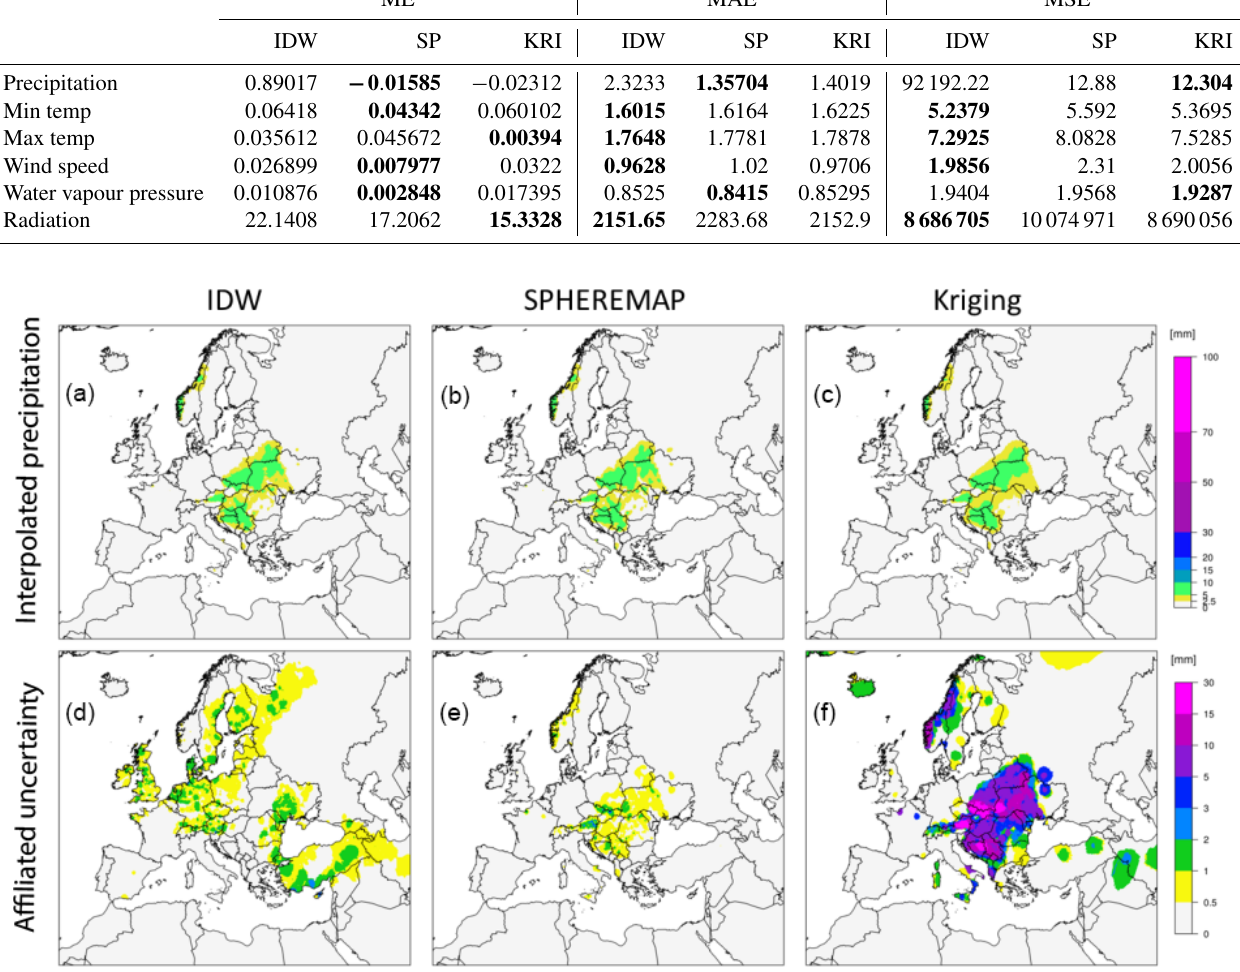
Figure 4. Gridded daily precipitation data (a–c) and the corresponding uncertainty fields (d–f) for 15 May 2014 as an example for IDW (a, d) , SPHEREMAP (b, e) , and Kriging (c, f)